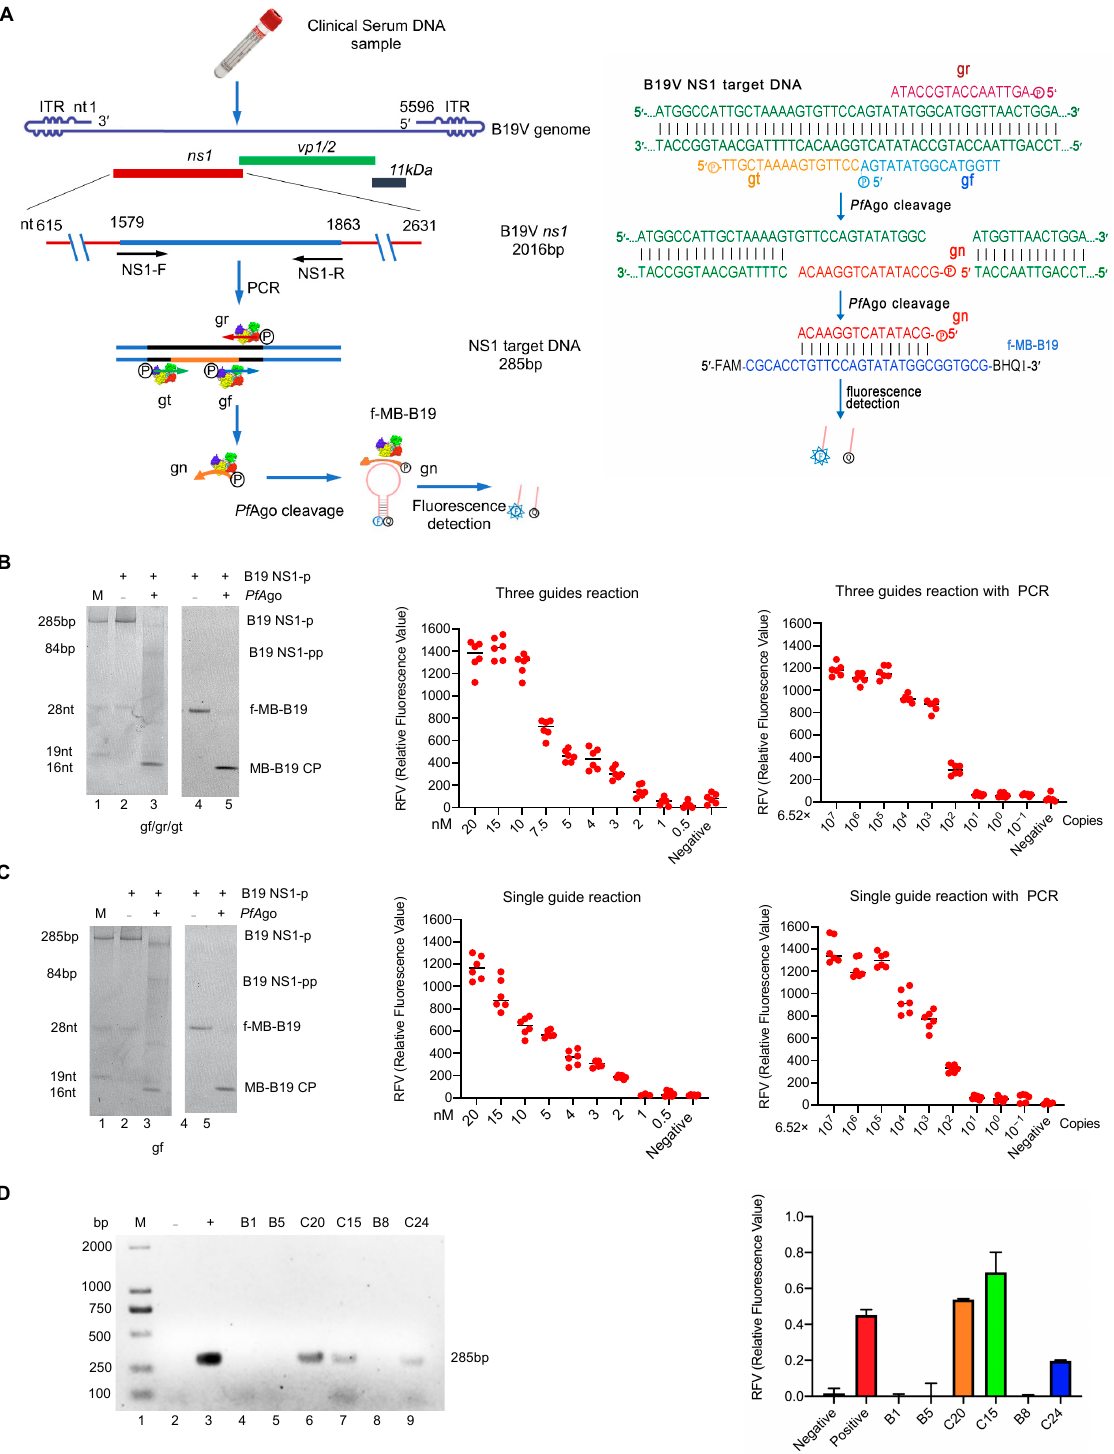
Figure 1. Establishment of the B19-NS1 PAND and its application in the clinical sample. ( A ) Schematic of B19-NS1 PAND workflow. The nucleotide location of the NS1 target region in B19V genome, the size of the PCR product, and the cleavage bands are indicated . The NS1 target PCR